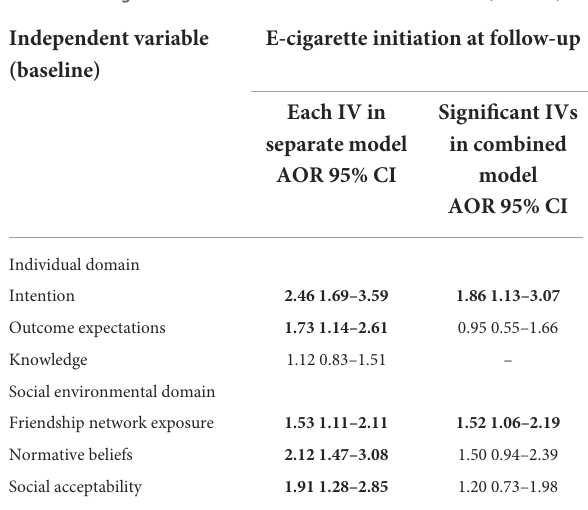
TABLE 2 Regression models predicting e-cigarette initiation at follow-up, with independent variables (IVs) first entered in separate models and significant IVs entered into a combined model ( n = 862).